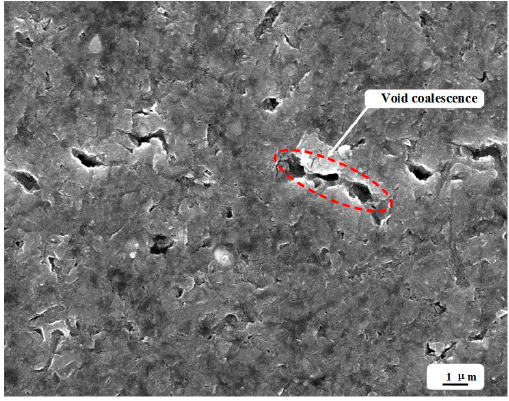
Figure 5. The necking stage during electromagnetic high-speed forming.